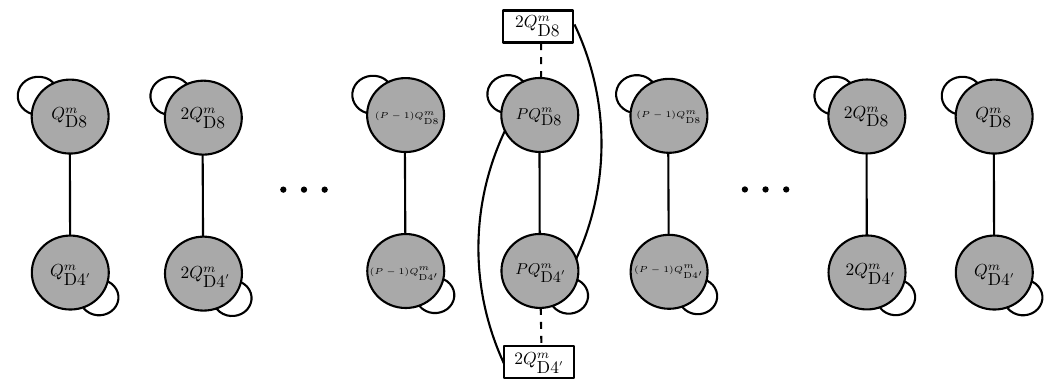
Figure 4 . Symmetric completed quiver associated to the NATD solution.